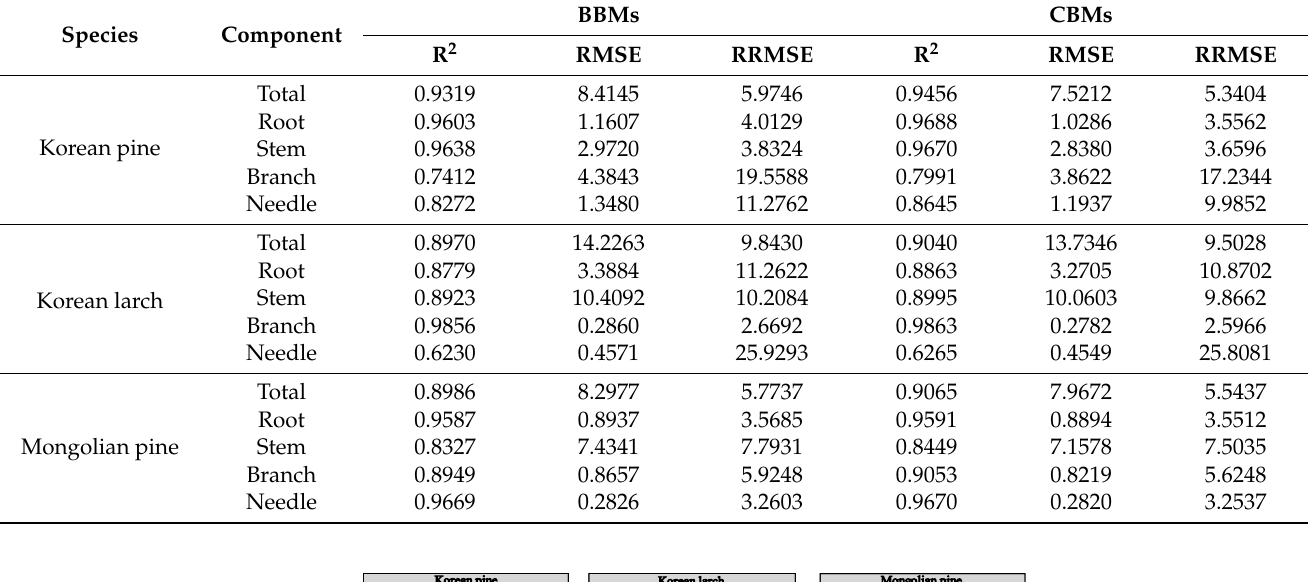
Table 5. Validation of the basic stand biomass models (BBMs) and climate-sensitive biomass models (CBMs) for three conifer species.